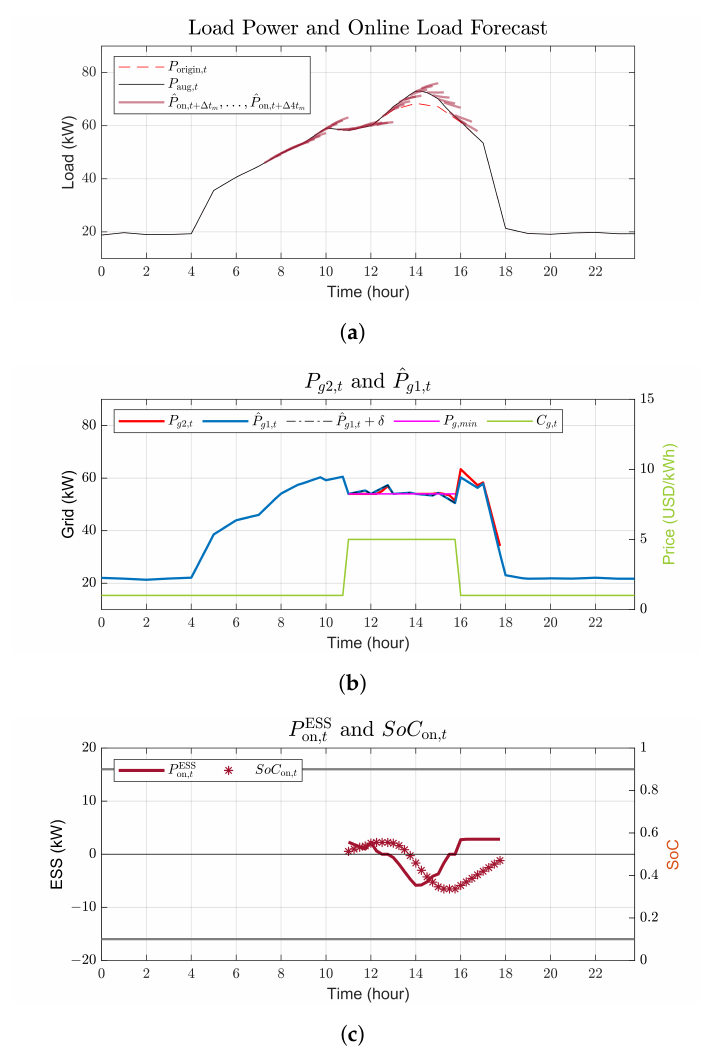
Figure 14. Online ESS operation at δ = 0. ( a ) Online load forecast, ( b ) The estimated power ˆ P g 1, t and real power P g 2, t from the main grid by using both ESS off and ESS on , ( c ) The amount of charging or discharging of ESS on and SoC on, t